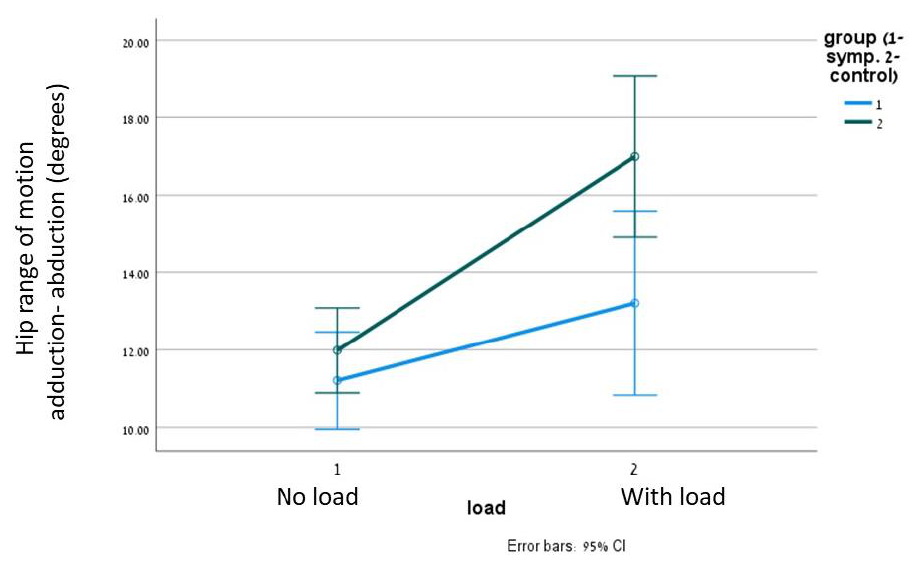
Figure 4. Hip joint range of motion adduction–abduction (in degrees) according to the PFPS, controls and load conditions (right leg).